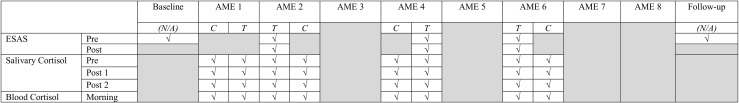
Simplified collection schedule for self- and proxy-report measures (ESAS), salivary cortisol, and blood cortisol. As shown in Figures 2, 3, the correspondence of AME sessions and data collection varied for children undergoing autologous and allogenic transplants; for illustrative purposes, this figure depicts days for a child undergoing an autologous transplant. Pre, Post, and Morning refer to the time of day during which samples were collected. Pre indicates that data collection occurred before the AME session, whereas Post indicates collection occurred after the session (Post 1 and Post 2) are used to indicate that data were collected twice after the session. C and T refer to control and treatment condition days within each pair of days on which data were collected for a given AME session.